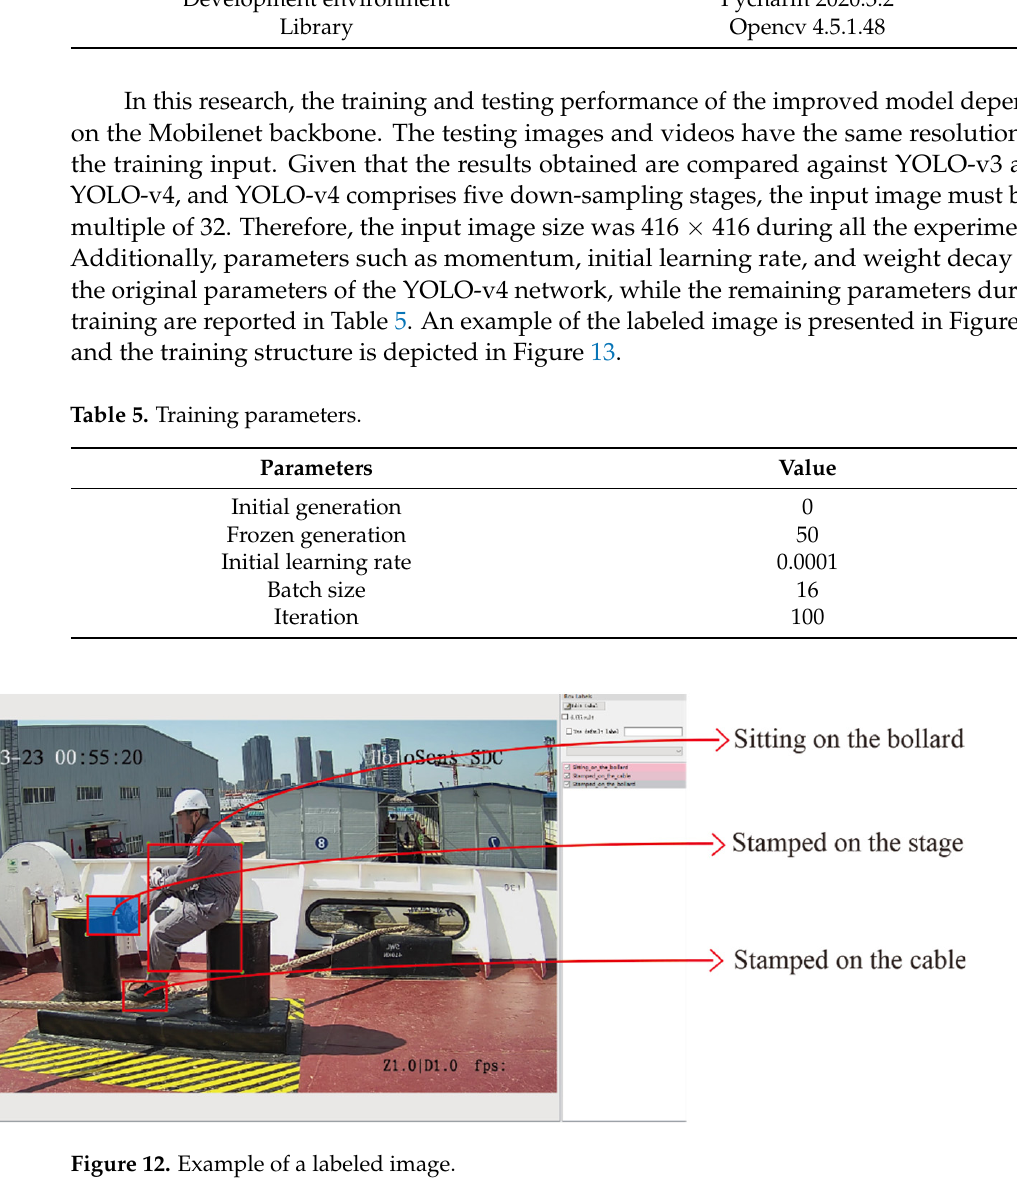
Figure 13. Training structure of the improved YOLO-v4. In this experiment, the training involved 100 epochs where the weight file was con- stantly updated, providing one file per epoch. These weights record the eigenvalues in the training set, which are used to predict the test set. During training, the weight file’s loss value decreases but will fluctuate after reducing to a certain extent. We chose the weight file providing the lowest loss value, as it achieves the best training effect. The cor- responding results are reported the Table 6. Table 6. The employed weight file during detection. Trained Method